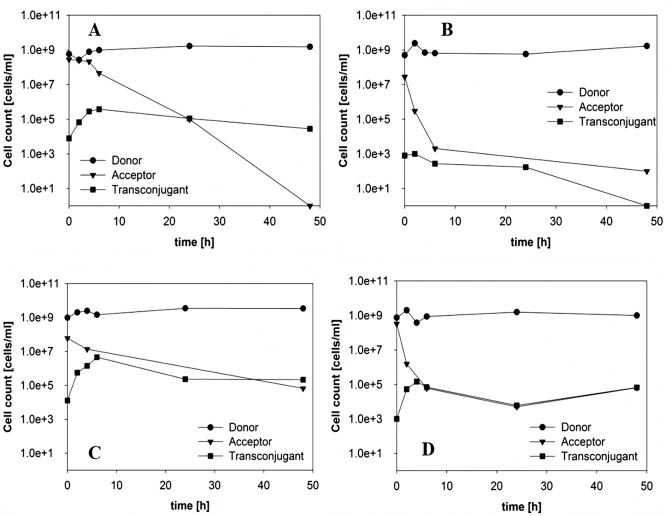
Transfer of pESBL-283 from ESBL242 (donor, ampR) to E. coli MG1655 (acceptor, chlorR).After donor and acceptor cells reached steady states in separate chemostats, cultures were mixed in a ratio of 1:1 in an empty reactor vessel and immediately supplied with fresh medium at the same dilution rate. Experimental conditions in each of the panels: (A) 0 μg/ml at D = 0.2 h-1, (B) 512 μg/ml ampicillin at D = 0.2 h-1, (C) 0 μg/ml at D = 0.4 h-1 and (D) 512 μg/ml ampicillin at D = 0.4 h-1.